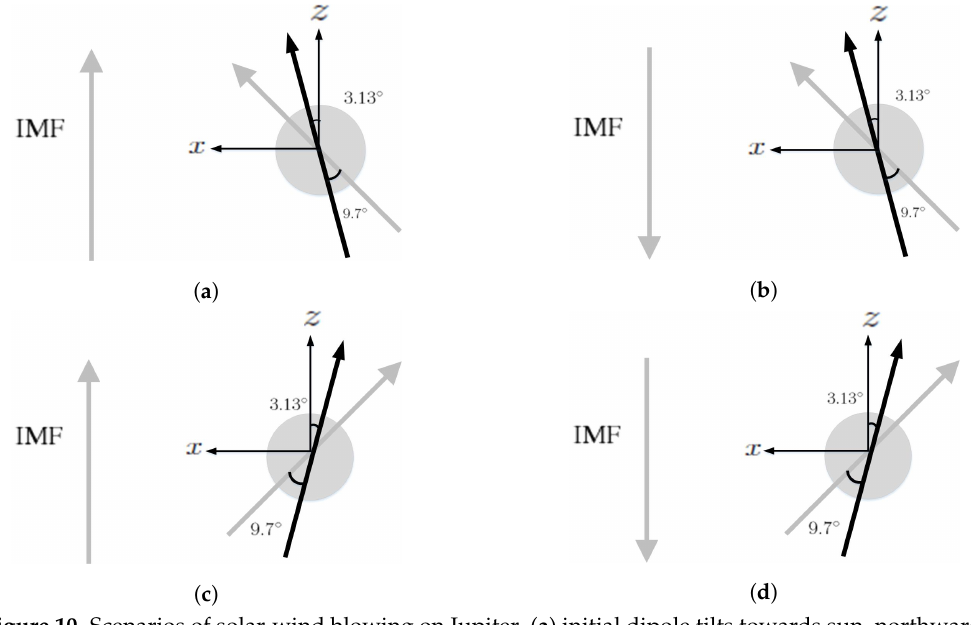
Figure 10. Scenarios of solar-wind blowing on Jupiter. ( a ) initial dipole tilts towards sun, northward IMF, ( b ) initial dipole tilts towards sun, southward IMF, ( c ) initial dipole tilts away from sun, northward IMF, ( d ) initial dipole tilts away from sun, southward IMF. The rotational axis (black arrow) tilts by 3.13 ◦ from the orbital normal and the dipole axis (grey arrow) tilts by 9.7 ◦ from the rotational axis, and lies on xz plane at t =